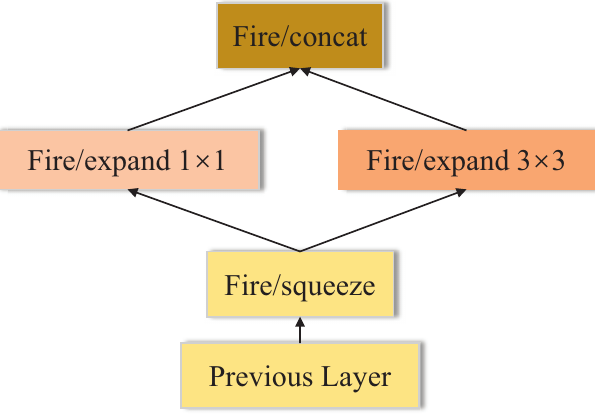
Figure 8. The architecture of